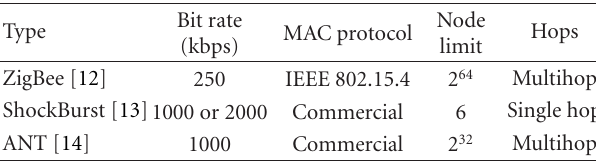
Table 1: Selected characteristics of some available 2.4 GHz